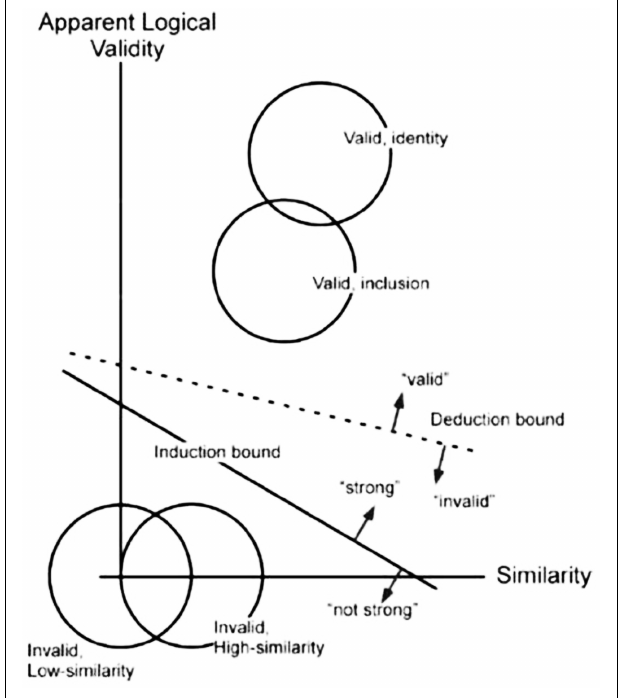
FIGURE 1 | Schematic two-dimensional signal detection model of induction and deduction. (Reproduced from Heit and Rotello, 2010).